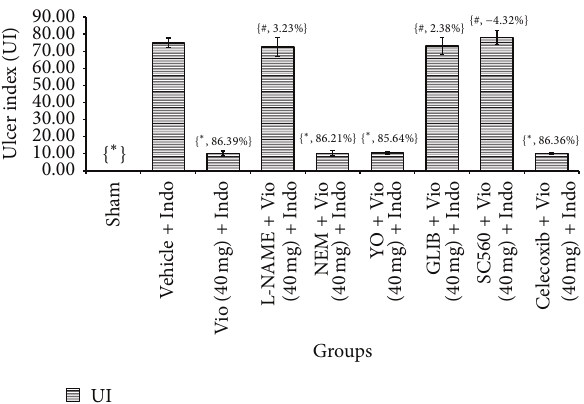
Figure 9: Effect of L-NAME (NOS inhibitor), NEM (NP-SH antagonist), yohimbine ( 𝛼 2 -receptors antagonist), glibenclamide (K + ATP- channels antagonist), SC560 (COX-1 inhibitor), and Celecoxib (COX-2 inhibitor) on gastroprotective activity of violacein against indomethacin-induced ulcer. Values are mean ± SD ( n = 6). ∗ 𝑃 < 0.05 compare vehicle + Indo with all the groups; # 𝑃 < 0.05 compare Vio (40mg)+IndowithL-NAME,NEM,YO,GLIB,SC560,orCelecoxib+Vio(40 mg)+Indo.Valuesinthebracesindicateulcerindexinhibition